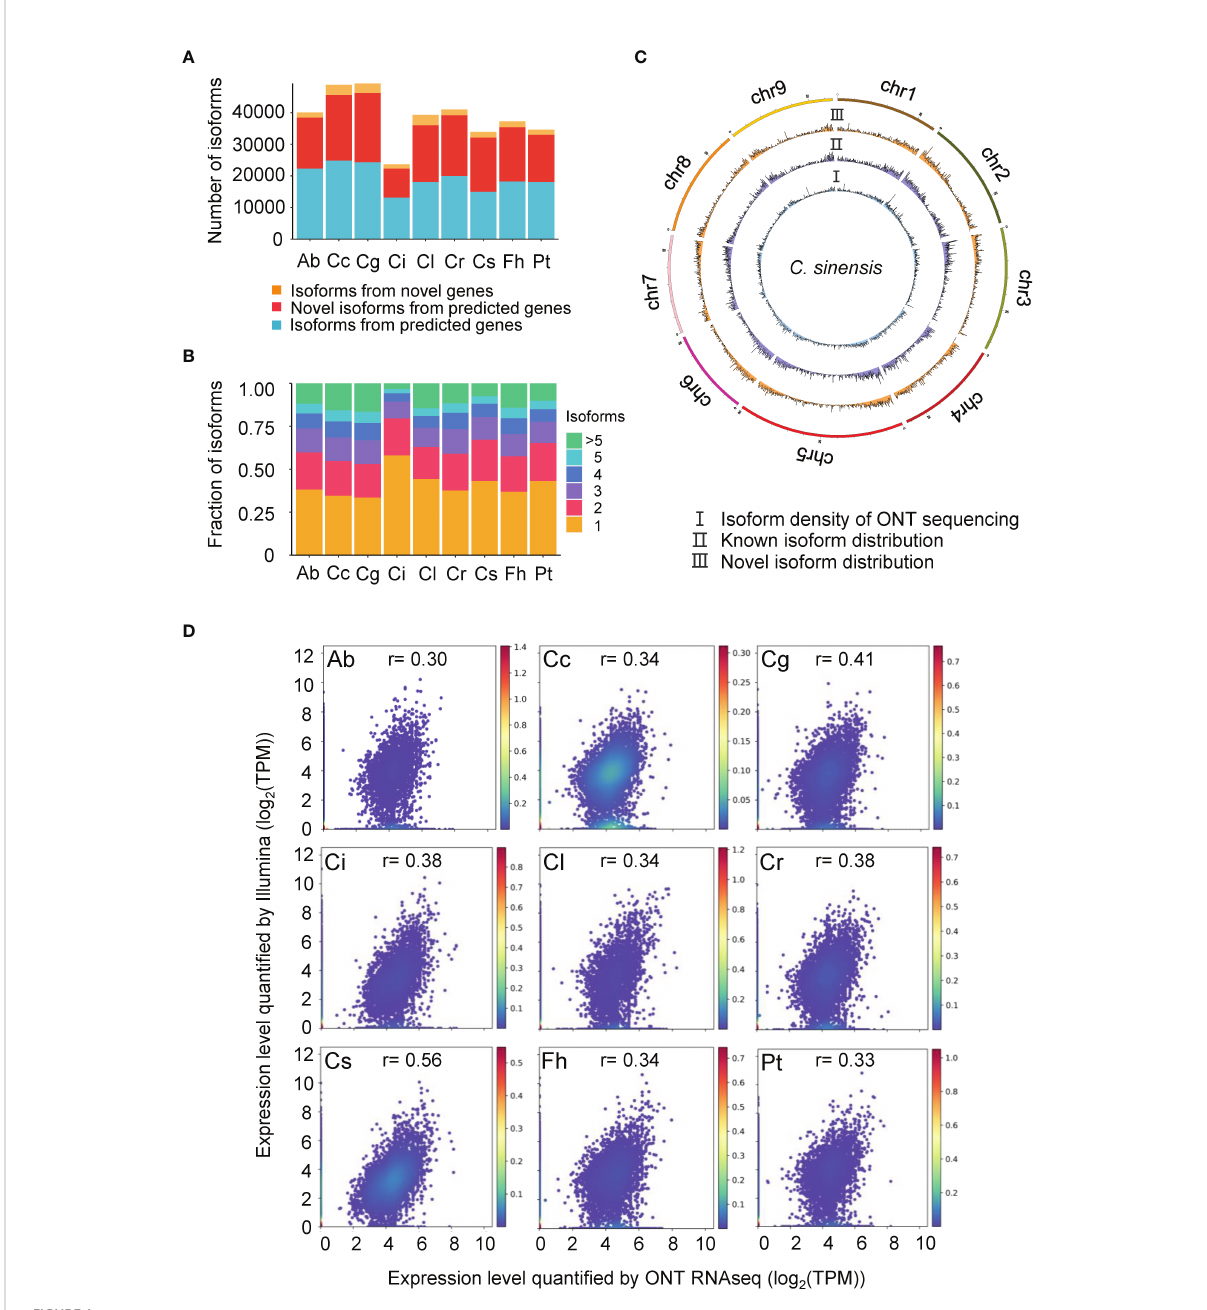
FIGURE 1 Characterization of different isoforms identi fi ed in 9 species. Ab, Atalantia buxifolia ; Cc, Citrus clementina ; Cg, Citrus grandis ; Ci, Citrus ichangensis ; Cl, Clausena lansium ; Cr, Citrus reticulata ; Cs, Citrus sinensis ; Fh, Fortunella hindsii ; Pt, Poncirus trifoliata . (A) Number of three types of isoforms (isoforms from predicted genes, novel isoforms from predicted genes, and isoforms from novel genes) identi fi ed across 9 species. (B) Fraction of isoforms per gene across 9 species. (C) Chromosomal distribution of isoforms generated by ONT RNAseq, using (C) sinensis as representative species. I: Isoform density of ONT sequencing; II: Known isoform distribution; III: Novel transcript distribution. (D) Gene expression correlations between Illumina and ONT RNAseq. Scatter plot shows gene expression for each gene determined by Illumina and ONT RNAseq for 9 species. Gene expression were given as Transcripts Per Million (TPM). Person r were calculated for each